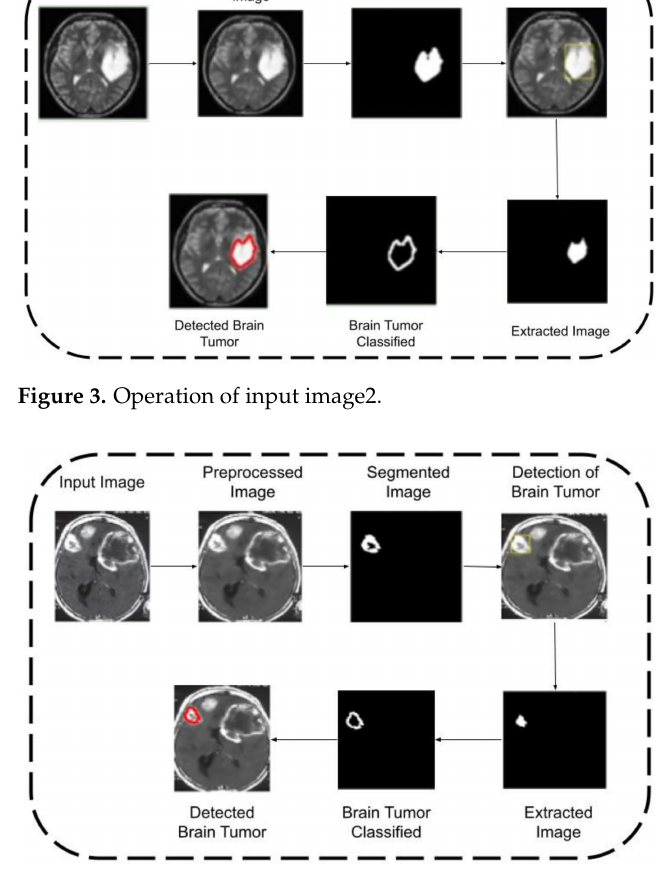
Figure 4. Operation of input